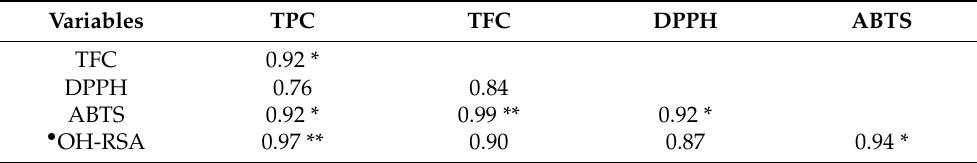
Table 2. Pearson correlation between phenolic contents and their antioxidant activities. Variables TPC TFC DPPH ABTS TFC 0.92 * DPPH 0.76 0.84 ABTS 0.92 * 0.99 ** 0.92 * • OH-RSA 0.97 ** 0.90 0.87 0.94